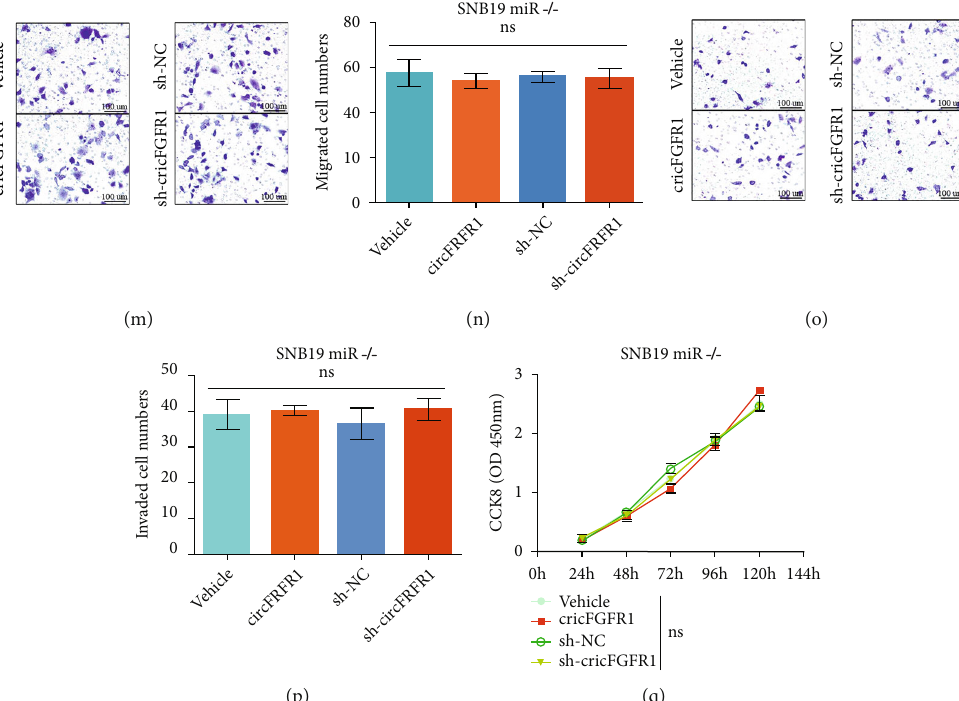
Figure 4: Hsa-miR-224-5p is necessary for circFGFR1-induced glioma oncogenicity. (a – h) SNB19 cells transfected with mi-NC, hsa- miR-224-5p, inhibitor NC, and inhibitor, respectively. (a) The expression of CXCR4 mRNA in those di ff erent groups analyzed by qPCR. (b, c) The expression of CXCR4 protein in those di ff erent groups analyzed by western blot. (d, e) The migration ability of those di ff erent groups analyzed by Matrigel-free Transwell assay. (f, g) The invasion ability of those di ff erent groups analyzed by Matrigel-based Transwell assay. (h) The proliferation ability of those di ff erent groups analyzed by CCK8 assay. (i) The expression of hsa-miR-224-5p in WT SNB19 cells and SNB19 miR-/- cells analyzed by qPCR. (j – q) SNB19 miR-/- cells overexpressing Vehicle, circFGFR1, sh-NC, and sh-circFGFR1, respectively, by transducing lentivirus and screening with puromycin. (j) The expression of CXCR4 mRNA in engineered SNB19 miR-/- stable cell lines analyzed by qPCR. (k, l) The expression of CXCR4 protein in engineered SNB19 miR-/- stable cell lines analyzed by western blot. (m, n) The migration ability of t engineered SNB19 miR-/- stable cell lines analyzed by Matrigel-free Transwell assay. (o, p) The invasion ability of engineered SNB19 miR-/- stable cell lines analyzed by Matrigel-based Transwell assay. (q) The proliferation ability of engineered SNB19 miR-/- stable cell lines analyzed by CCK8 assay. The data are presented as the means ± SD , n = 3 experiments in (a – q), ∗ p < 0 : 05 , ∗∗ p < 0 : 01 , ∗∗∗ p < 0 : 005